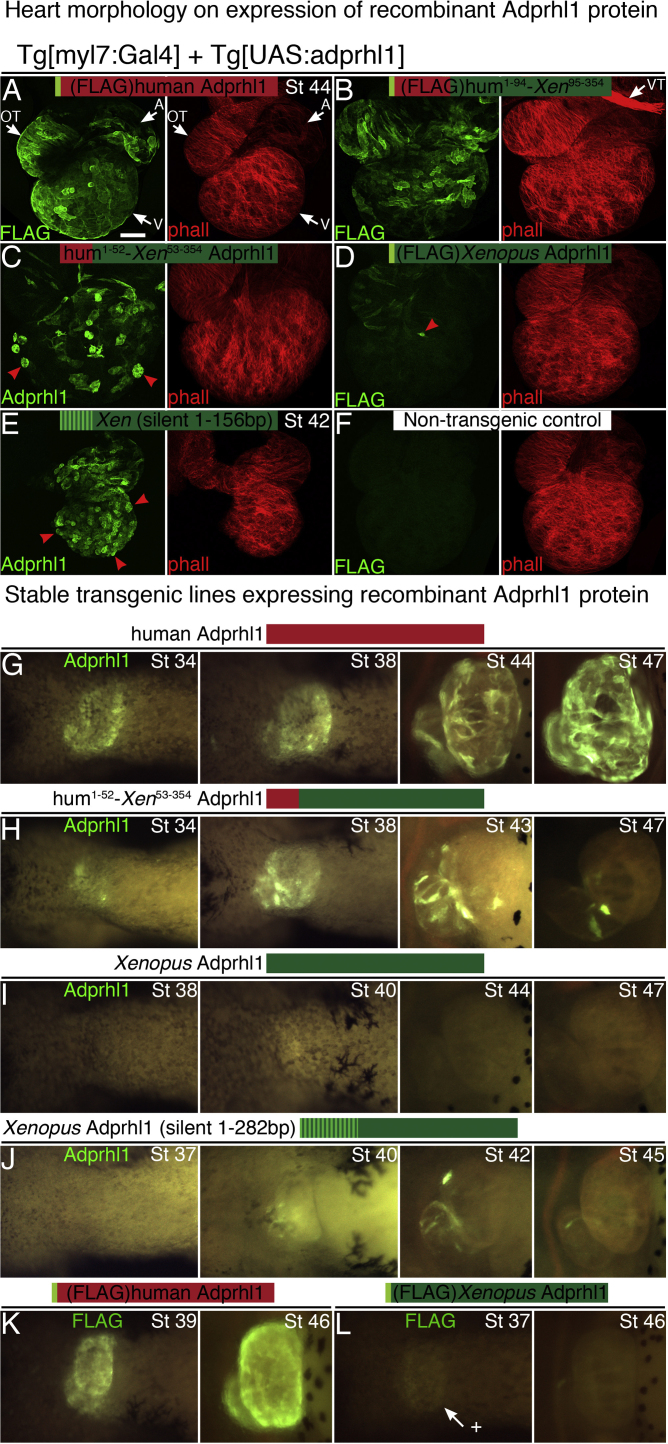
Expression of recombinant Adprhl1 protein in transgenic hearts. A–F: Expression of Adprhl1 protein in the heart of founder generation transgenic tadpoles. Each carries the Tg[myl7:Gal4] driver plus a new integration of an adprhl1 responder. A: Tg[UAS:(FLAG)human ADPRHL1]. B: Tg[UAS:(FLAG)hum1-94-Xen95-354adprhl1]. C: Tg[UAS:hum1-52-Xen53-354adprhl1]. D: Tg[UAS:(FLAG)Xenopus adprhl1]. E: Tg[UAS:Xenopus adprhl1(silent 1-156bp)]. F: Non-transgenic sibling control heart. Dissected hearts are shown, anterior view, at stage 44 (A–D, F) and stage 42 (E). Cells with a rounded morphology that protrude from the ventricle surface, found in hybrid and silent mutation transgenics are indicated (red arrowheads). The heart (E) represents a transgenic containing large numbers of Xenopus Adprhl1-positive cells and thus shows abnormal cardiac chamber development. A, B, D, F: Anti-FLAG (green) and phalloidin actin stain (red). C, E: Anti-Adprhl1 and phalloidin. Scale bar (A)=100 µm. V, ventricle; A, atrium; OT, outflow tract; VT ventral transverse skeletal muscle, that was not dissected away from the heart (B). G–L: Adprhl1 protein expression in embryos representing six stable Tg[UAS:adprhl1] transgenic lines. G: Tg[UAS:human ADPRHL1]. H: Tg[UAS:hum1-52-Xen53-354adprhl1]. I: Tg[UAS:Xenopus adprhl1]. J: Tg[UAS:Xenopus adprhl1(silent 1-282bp)]. K: Tg[UAS:(FLAG)human ADPRHL1]. L: Tg[UAS:(FLAG)Xenopus adprhl1]. The developmental stage series highlights the transient nature of Adprhl1 over-expression with the hybrid and silent mutation transgenes. Ventral views, anterior to the left.